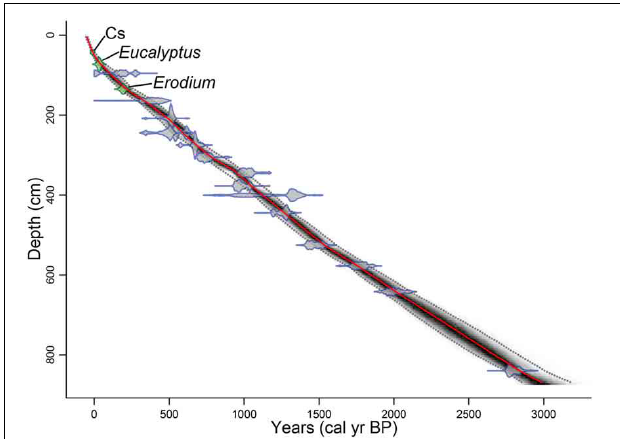
FIGURE 3 | Age model for core Z1C. Best fit age for each depth (red line), the probability calculation (darker color indicates more likely calendar age), and 95% confidence interval (gray dotted line). Calibrated 14 C dates (blue), and first occurrence of exotic pollen and 137 Cs peak (green), all with their 2-sigma error